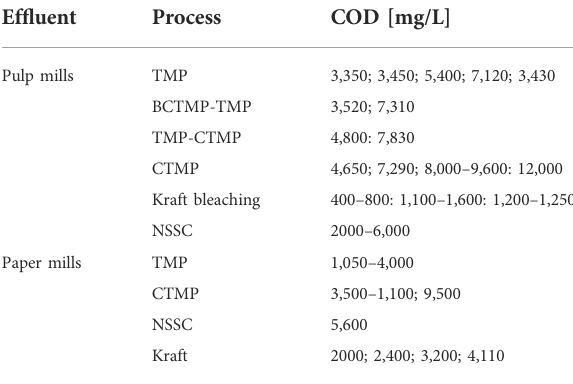
TABLE 1 COD of ef fl uents from high yield and chemical pulping processes.